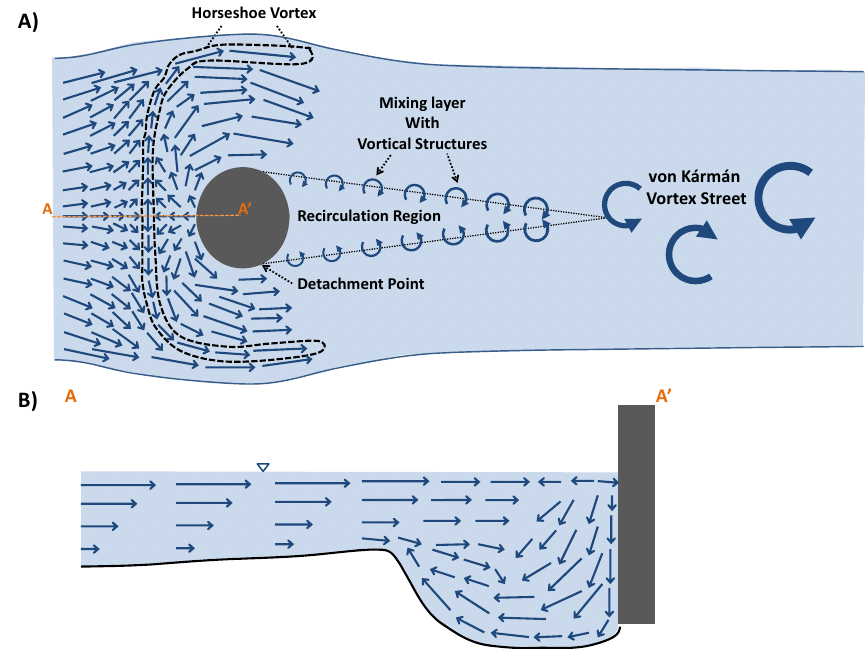
Fig. 1. Plan view (A) and cross-sectional view (B) schematic of flow field around a circular cylinder. (Figure adapted from the work of Kirkil et al., 2006, Hinterberger et al., 2007, and Shen and Diplas,